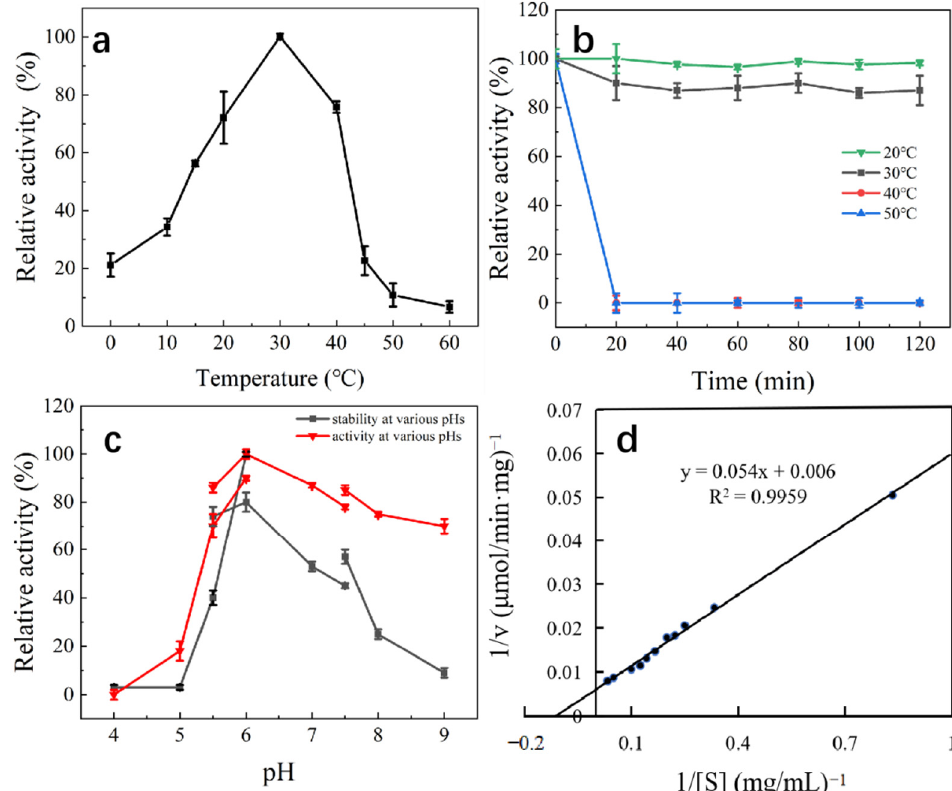
Figure 3. Analysis of the enzymatic properties of PsDex1711. ( a ) PsDex1711 optimal catalytic temperature; ( b ) PsDex1711 temperature stability; ( c ) Optimal catalytic pH and stability of PsDex1711; ( d ) Enzyme kinetic constants of PsDex1711.